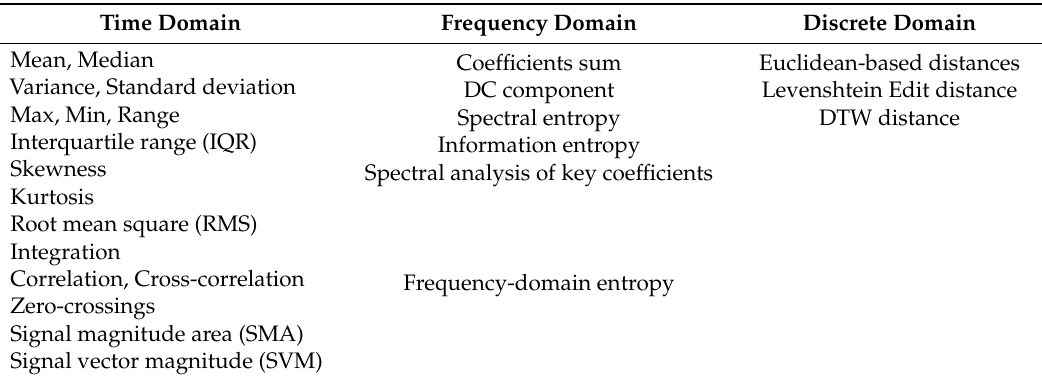
Table 1. Summary of features.